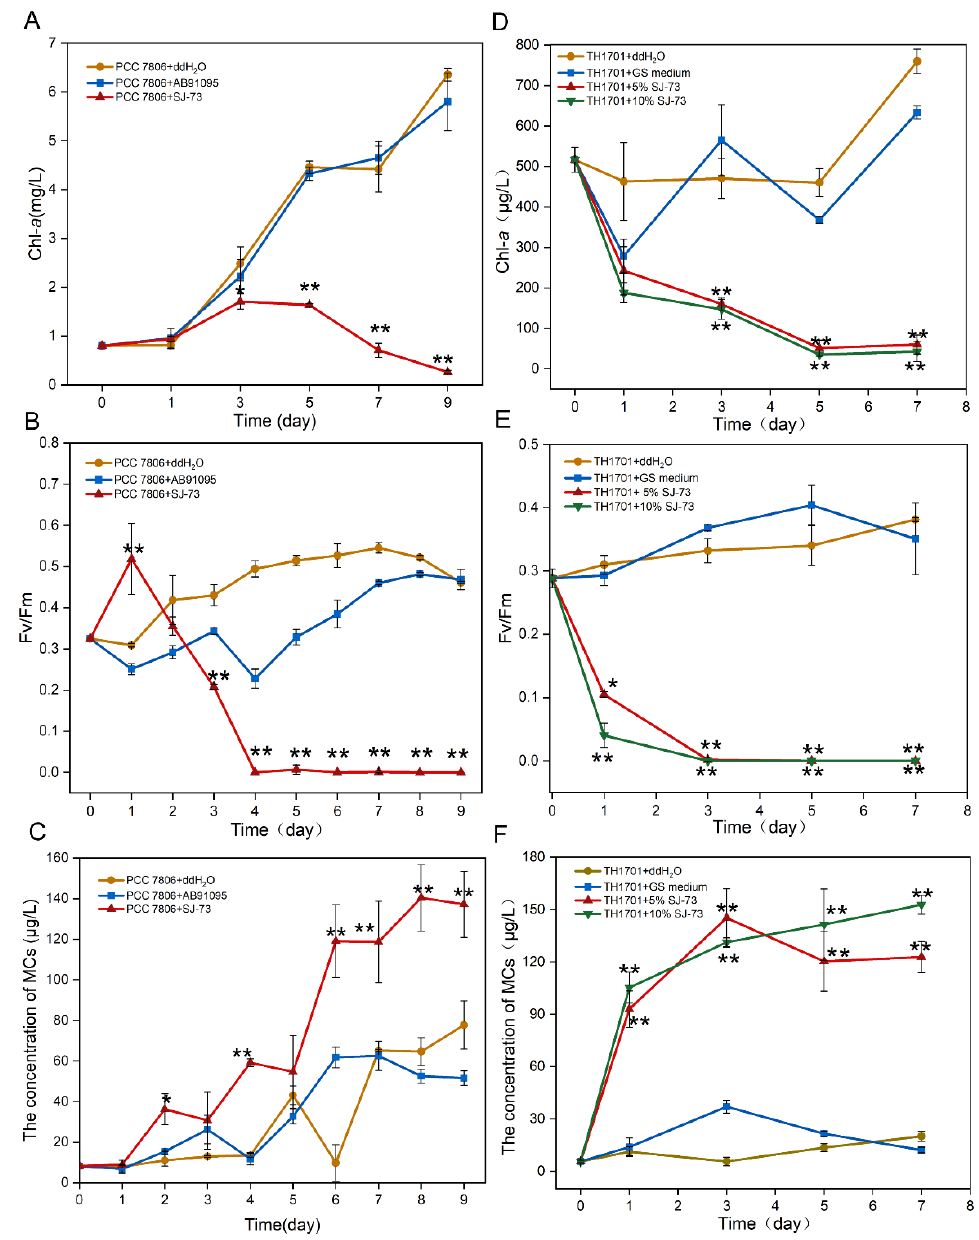
Figure 3. Effects of bacterium SJ-73 on the concentration of Chl- a ( A , D ), photosynthetic activities ( B , E ) and extracellular MCs ( C , F ) of unicellular M. aeruginosa PCC 7806 and colonial M. aeruginosa TH1701 cultures. Bars represent the standard errors of the means for triplicate. Significant differences are shown by asterisks: *, p < 0.05; **, p < 0.01.